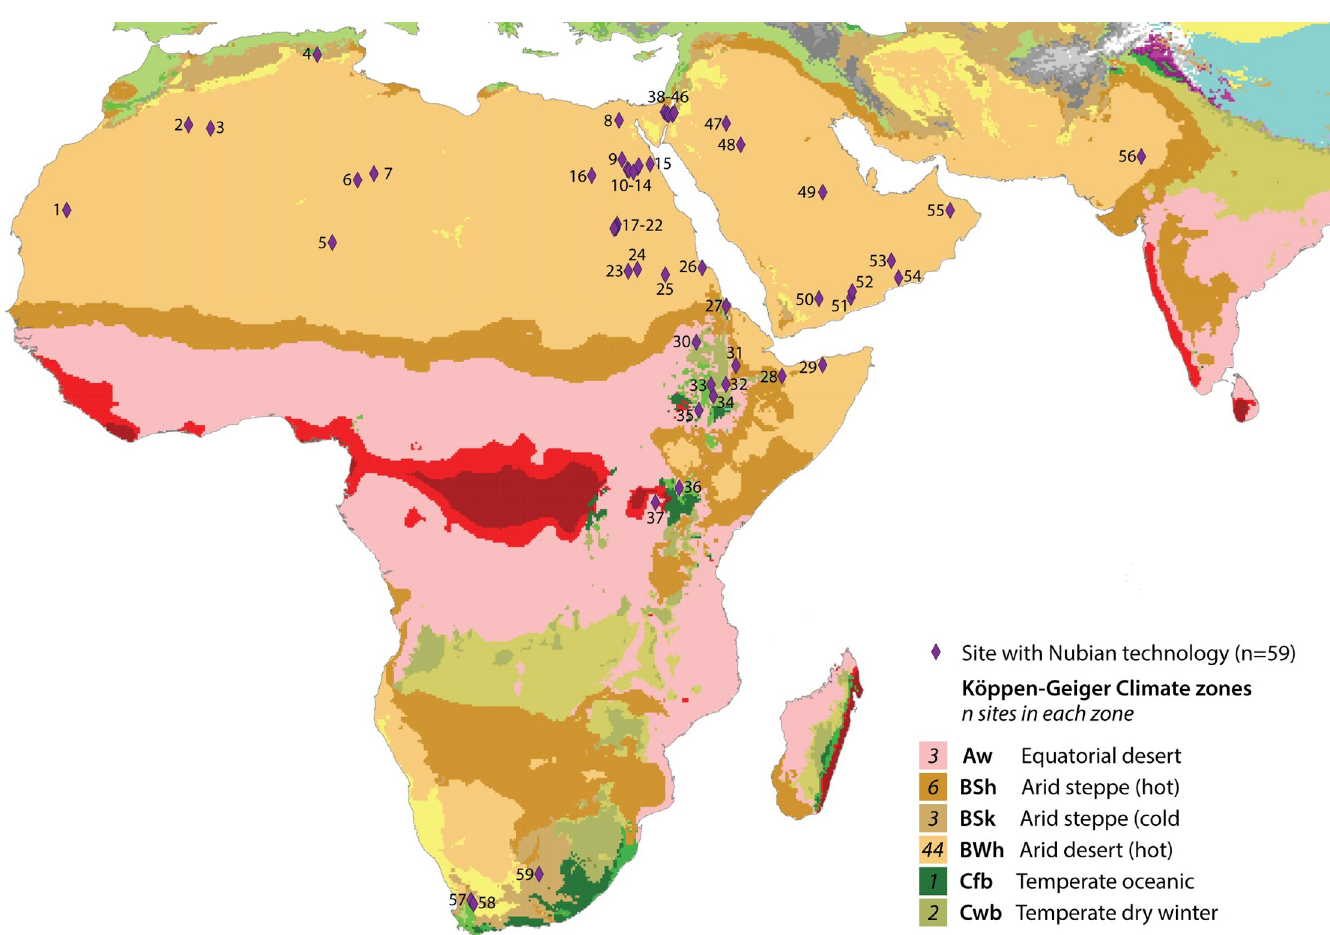
Fig 18. Map showing sites with Nubian technology in relation to Ko¨ppen-Geiger climate zones. BSh, BSk and BWh are arid climate areas. Koppen-Geiger Climate data from CliMond.org, after [140]. Open-source spatial data from NaturalEarthData.com. Site numbers refer to Table G in S1 Appendix.